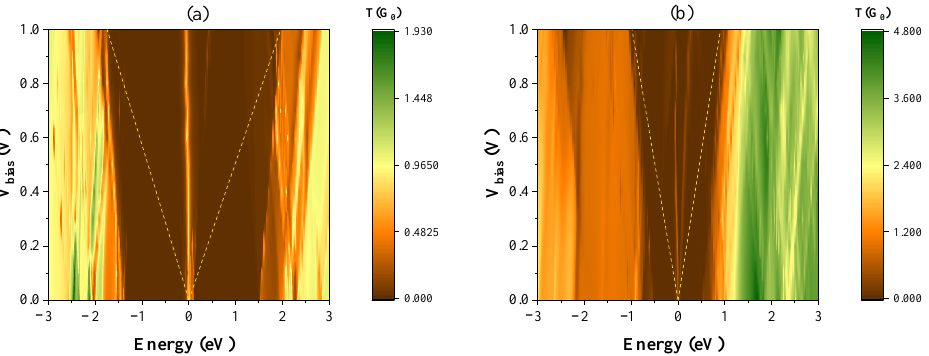
Figure 12. The total transmission spectrum as a function of the applied bias voltage and electron energy for the devices containing ( a ) graphene, ( b ) silicene zigzag trigonal nanodiscs (N = 2) as a central region and sandwiched between two semi-infinite electrodes. The dashed yellow lines represent the bias